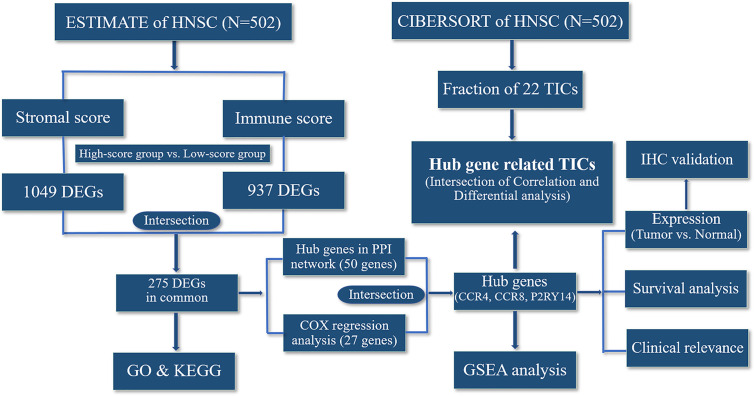
Flowchart of the entire analysis.